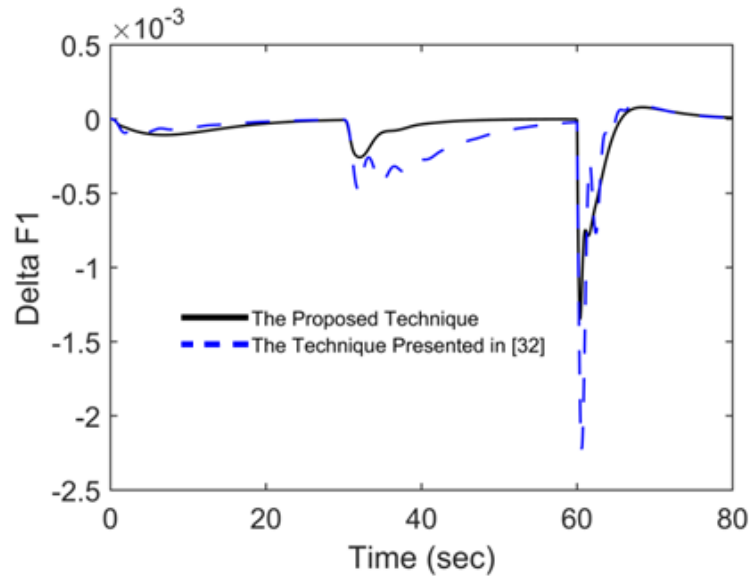
Figure 6. Frequency deviation (p.u.) in area 1 under various load variations.